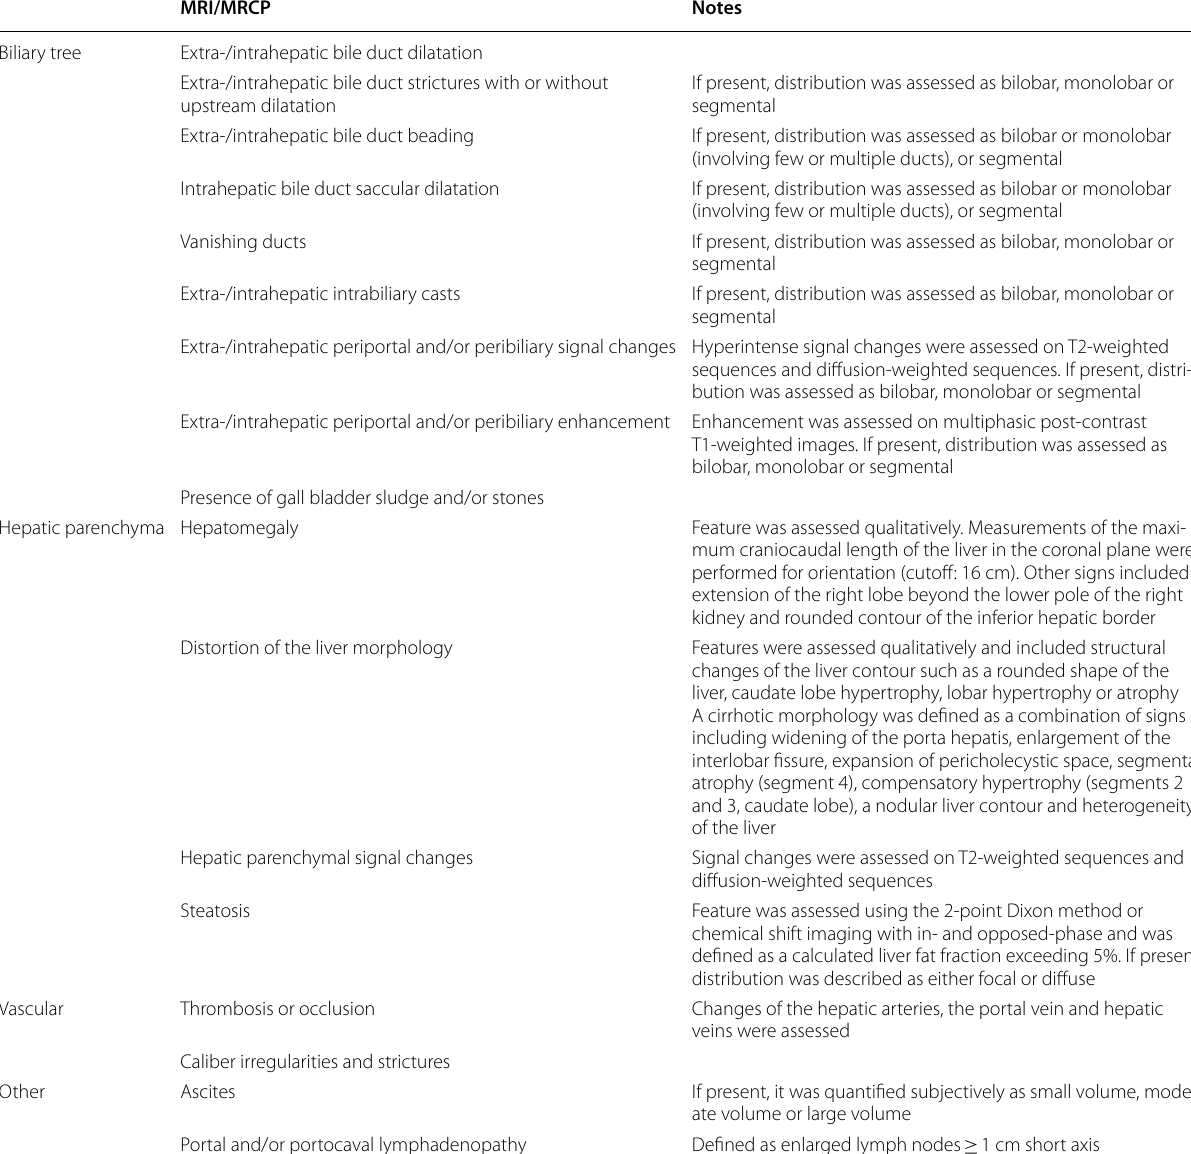
Table 1 List of imaging features assessed on MRI and MRCP MRI/MRCP Notes Biliary tree Extra-/intrahepatic bile duct